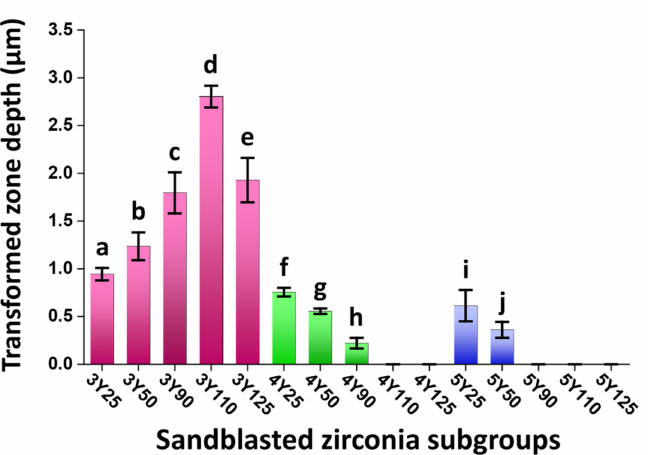
Figure 10. Means of the tetragonal to monoclinic phase transformed zone depth obtained from FIB/SEM images. A two-way ANOVA revealed that there was a statistically significant interaction between the effects of zirconia grade and the abrasive particle size on the transformed zone depth ( p < 0.05). Error bars denote standard deviations around the means. Means with different lowercase letters show statistically significant differences within each zirconia grade based on a Tukey honestly significant difference multiple comparison test ( p < 0.05). For 3Y subgroups, 3Y110 induced the deepest transformed layer up to 2.9 µ m. For 4Y subgroups, 4Y25 induced the deepest transformed layer up to 0.8 µ m. For 5Y subgroups, 5Y25 induced the deepest transformed layer up to 0.7 µ m. No isolated transformed zone was found under the surface beyond 4Y110 for 4Y subgroups and beyond 5Y90 for 5Y